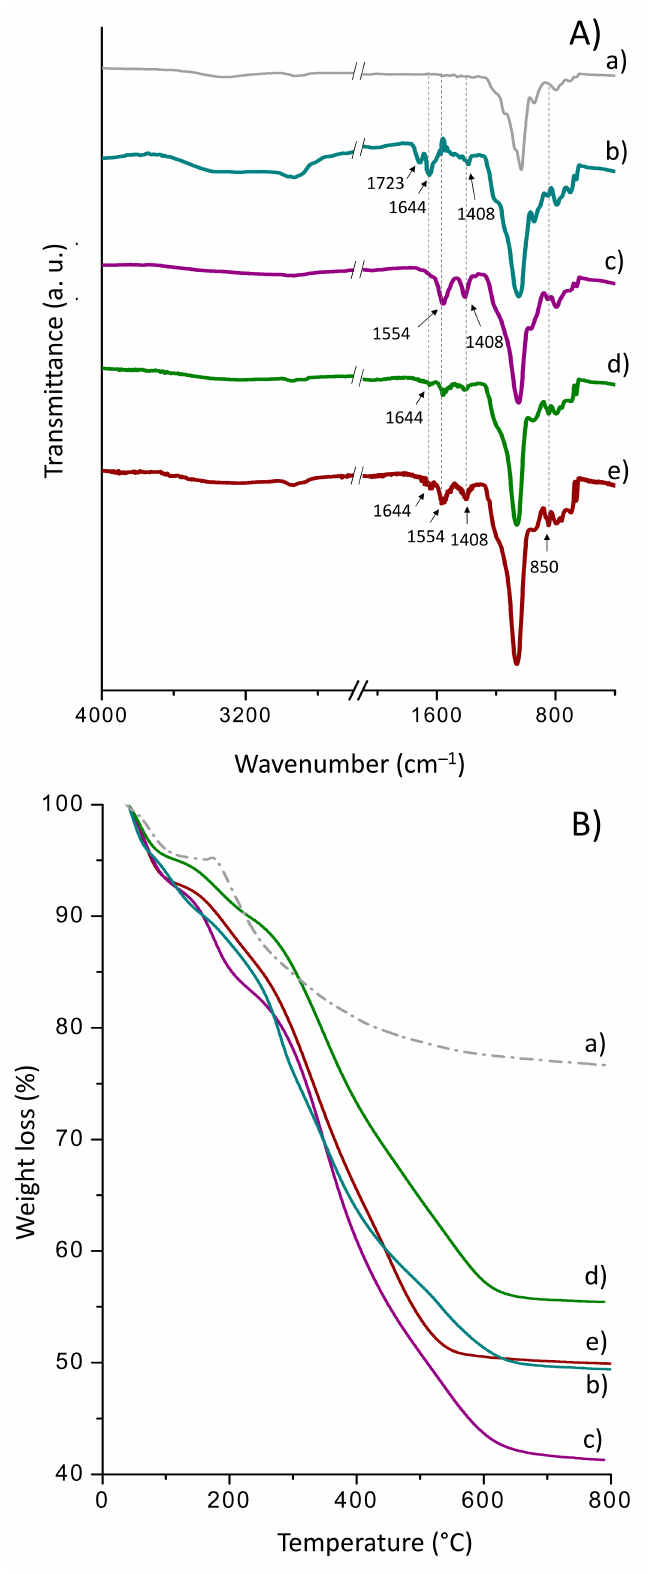
Figure 5. ATR-FTIR spectra ( A ) and TG curves ( B ) for ( a ) as-synthesized Sihgel, ( b )